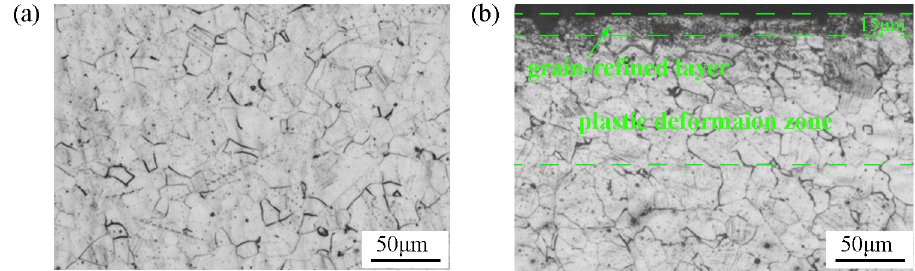
Figure 3. Typical cross-sectional optical microscopy (OM) of ( a ) the as-received sample and ( b ) the USR sample in the top-surface layer.